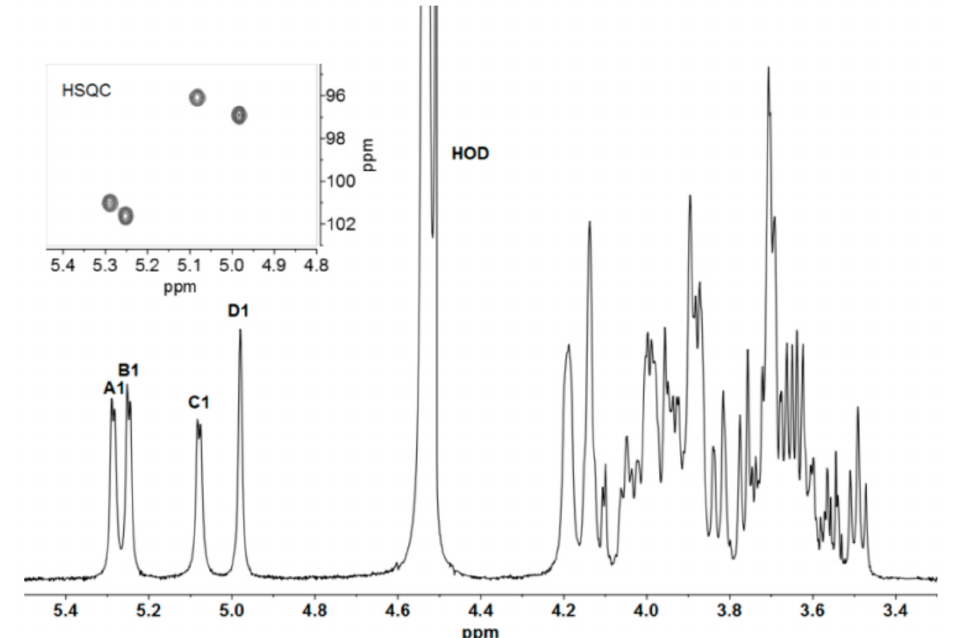
Figure 1. 1 H NMR spectrum recorded at 50 ◦ C of Epol H111-INS in 0.3 M deuterated sodium hydroxide (NaOD) extracted from the biofilm of Burkholderia cenocepacia H111. Anomeric protons have been